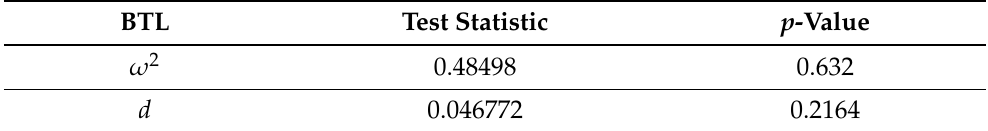
Table 2. KS and CVM testing with the CDF of the BTL.